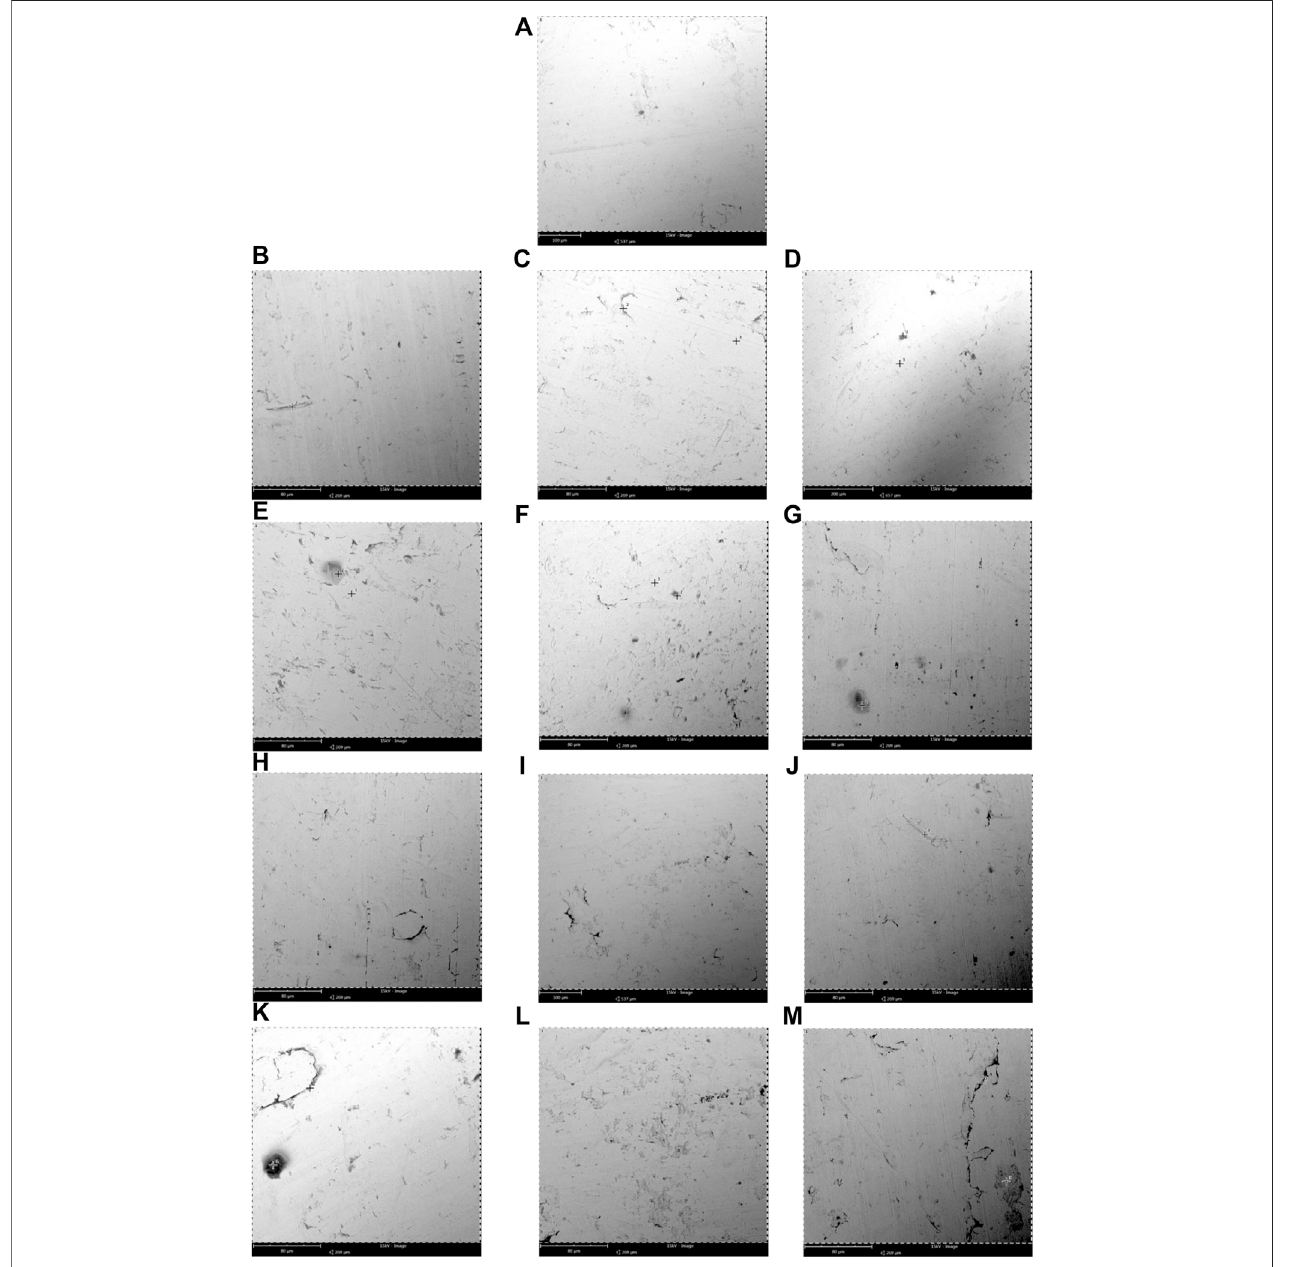
FIGURE 3 | Scanning electron microscopy (SEM) micrographs of corrosion observed at the immersed surface of the biodiesel-diesel blend mixtures with different immersion durations for stainless steel 316 (A) 0 day, (B – G) B5, B10, B15, B20, B25, and B30 at 300 days, (H – M) B5, B10, B15, B20, B25, and B30 at 600 days at room temperature (25 ° C – 30 °